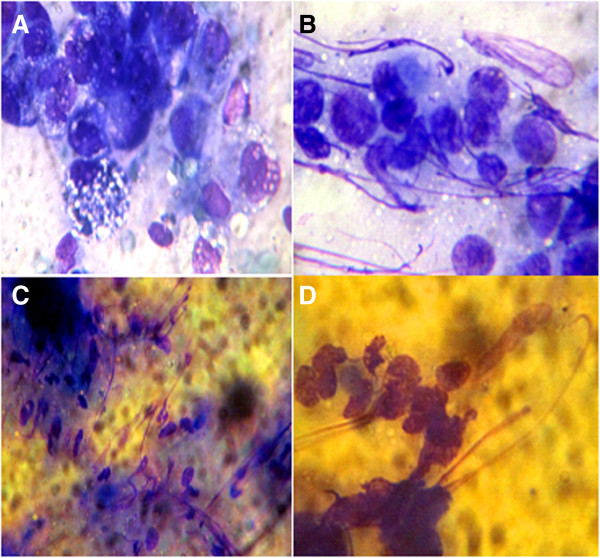
Evaluation of accuracy of fine needle aspiration cytology for diagnosis of feline mammary tumours. A: Malignant epithelial cells; nuclei exhibit nuclear criteria of malignancy (variable size, macronucleoli); nuclei superimposed and in different focal planes, together with variation in cell (anisocytosis) and nuclear. (anisocytosis) size are present and abundant vacuoles, May-Graun-Giemsa staining method, 1000X. B: Cytological appearance of spindle shape cells (tomour from the cat n°1) and pleomorphic malign epithelial cells in adenocarcinoma, May-Grünwald Giemsa (MGG) staining method, 1000X. C and D: Myoepithelial cells (spindle shape) with abundant chromatin granules, irregular in shape, and unevenly dispersed throughout nucleus in adenocarcinoma, May-Grunwald-Giemsa, X 400 and X 1000.